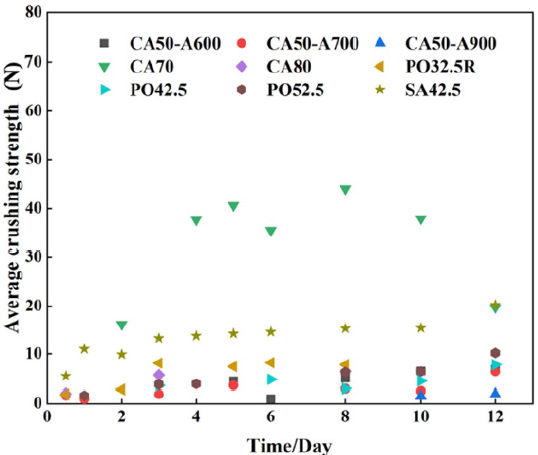
Figure 5. Crushing strengths of the cylindrical samples as a function of aging time for different cements.